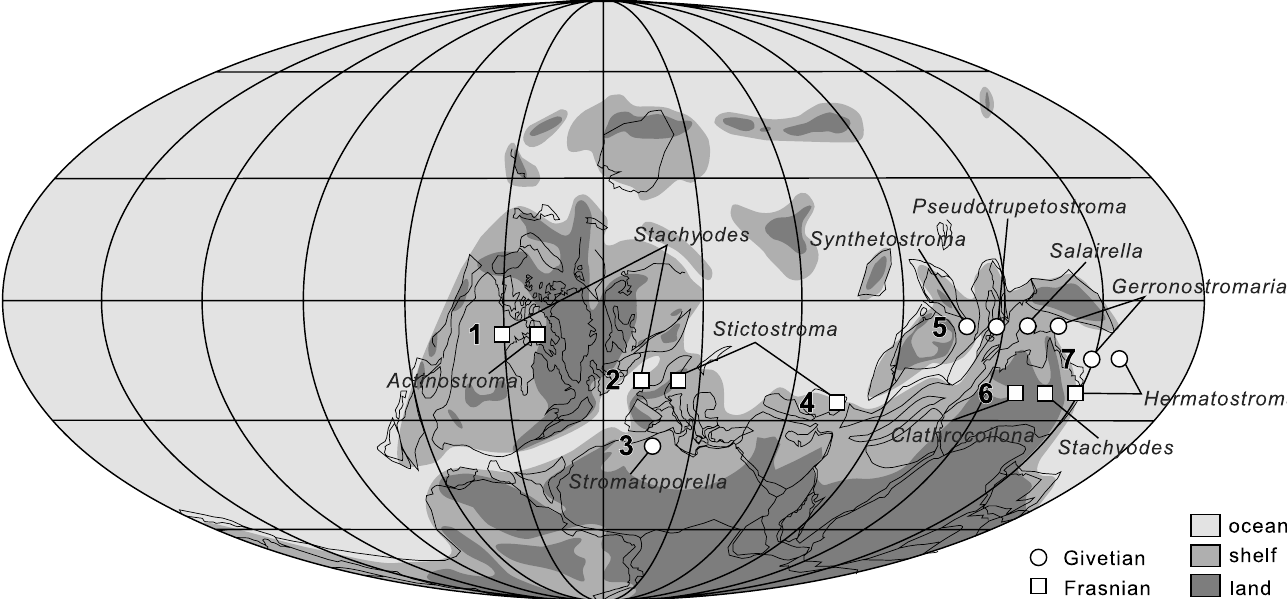
Fig. 13. Palaeogeographic distribution of the reef-building laminar stromatoporoid genera during the Givetian and Frasnian (Middle–Late Devonian). Localities: 1, Northwest Territories, Canada (MacNeil and Jones 2016); 2, Dinant Basin, southern Belgium (Da Silva et al. 2011a, b); 3, Anti‐Atlas, Morocco (Jakubowicz et al. 2019); 4, Esfahan, central Iran (Mistiaen and Gholamalian 2000); 5, Guizhou, South China; 6, Canning Basin, western Australia (Cockbain 1984); 7, Queensland, eastern Australia (Cook 1999). Palaeogeographic map is based on Golonka